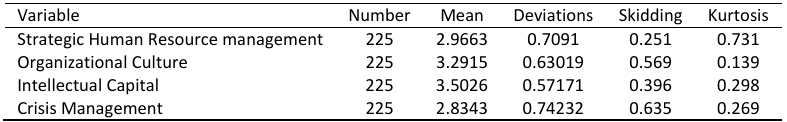
Table 2: Statistical description of the variables of the study model Table 2. Statistical description of the variables of the study model